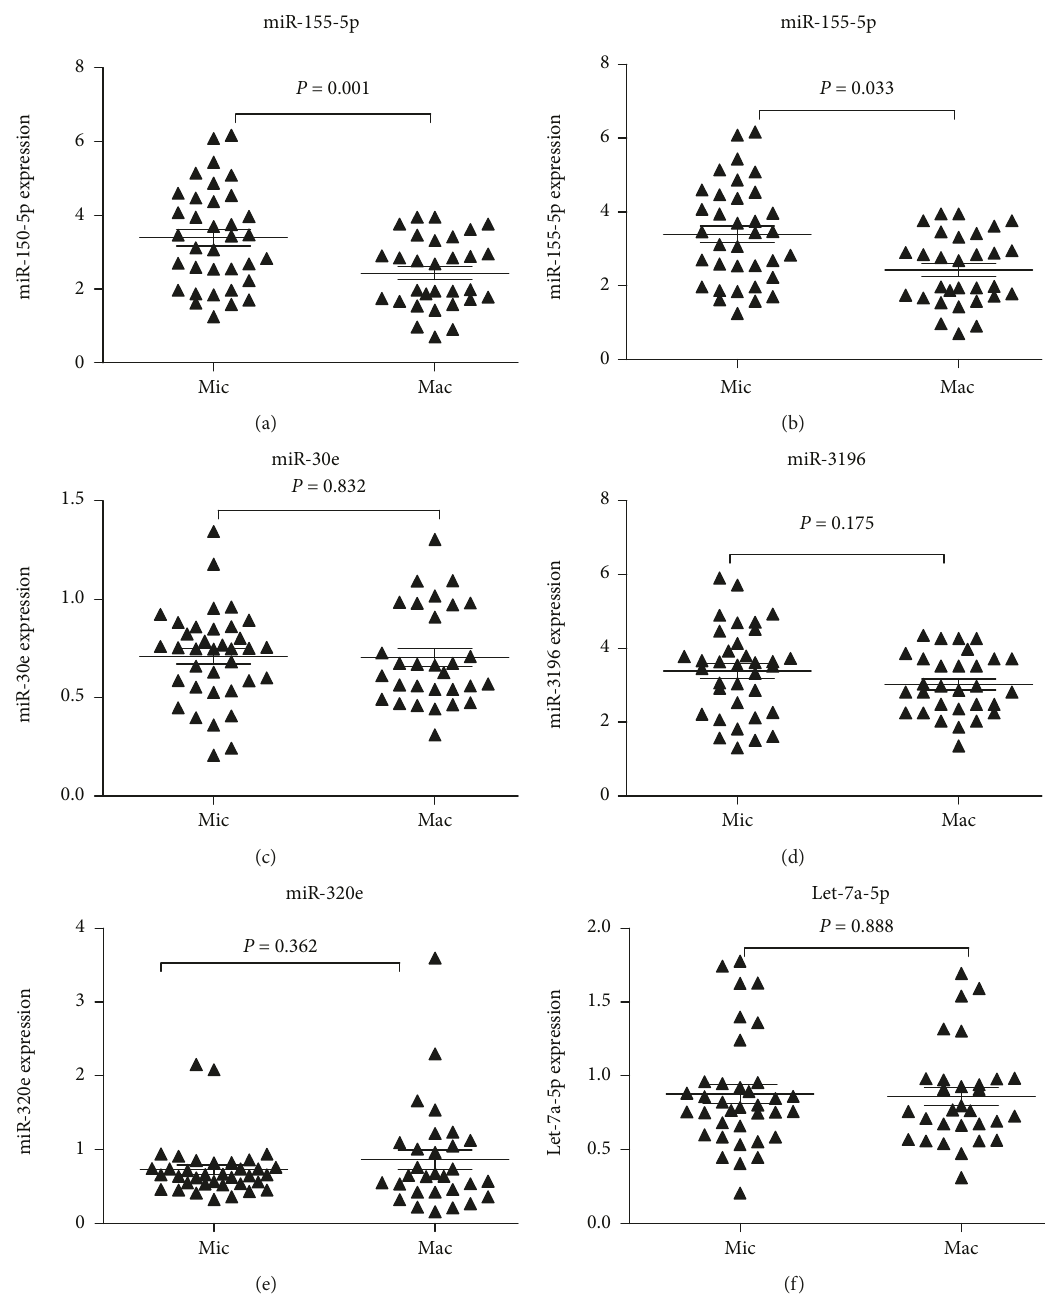
Figure 4: Comparison of the expression levels of miRNAs between the Mac and Mic groups. The miRNA expression levels were determined by quantitative real-time PCR. The expression of miR-150-5p (a) and miR-155-5p (b) was approximately 2.3-fold ( P = 0 001 ) and 1.5-fold ( P = 0 033 ) higher in the Mic group, when compared to the Mac group, respectively. There were no signi fi cant di ff erences in the expression levels of miR-30e (c), miR-3196 (d), miR-320e (e), and let-7a (f) between these two groups. Mic: microalbuminuria ( n = 36 ); Mac: macroalbuminuria ( n = 30 ). The error bars are presented as standard error of the mean